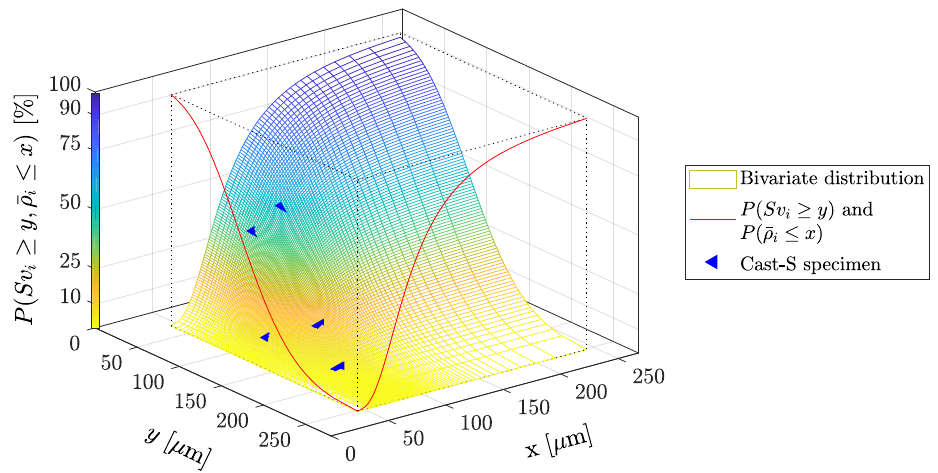
Figure 17. T6 P1 bivariate distribtion of Sv i GEV distribution and ρ